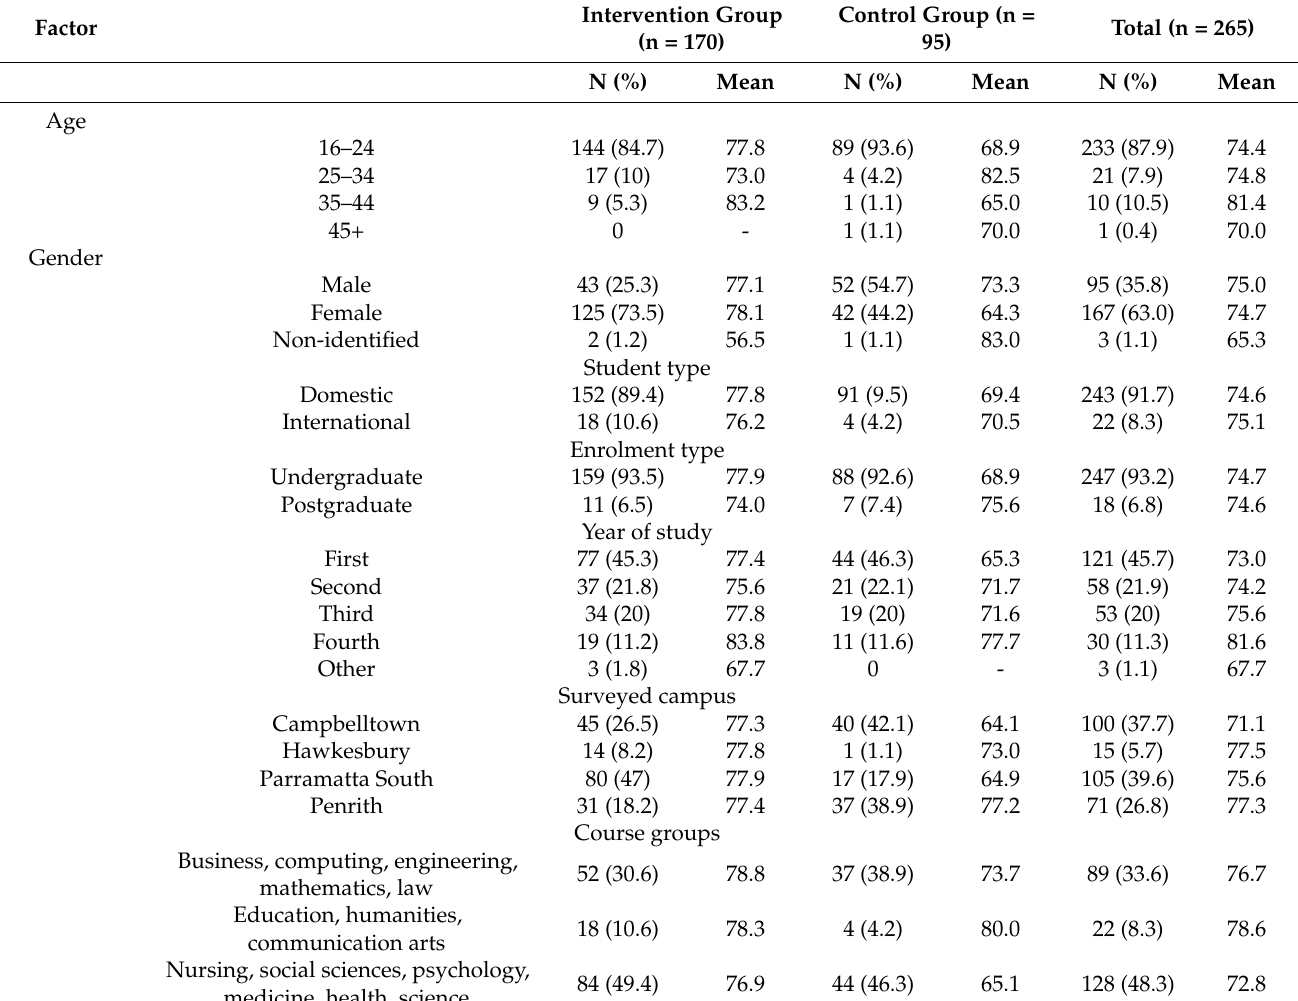
Table 1. Characteristics of the participants and PANAS mean